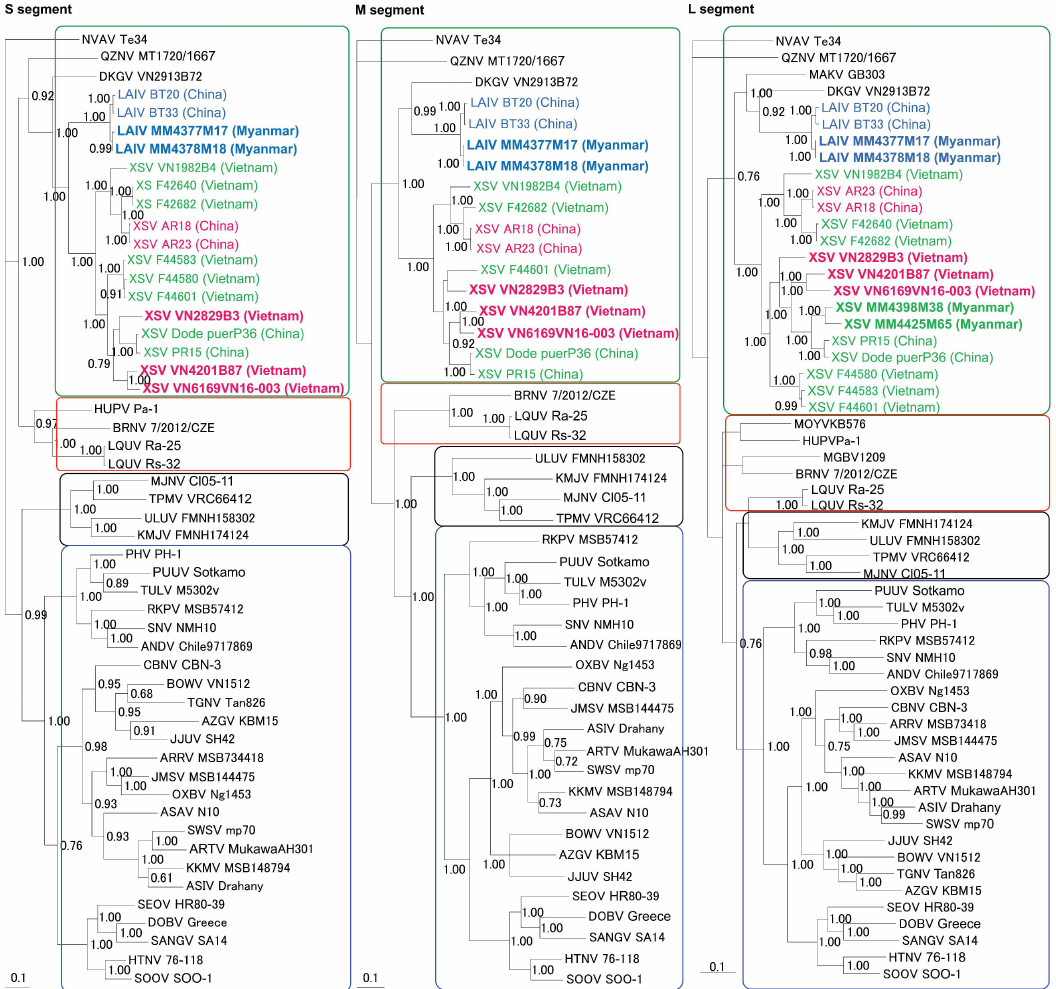
Figure 3. Phylogenetic trees, based sequences of the S-, M-, and L-genomic segments, respectively, generated by the Bayesian Markov chain Monte Carlo estimation method, under the GTR + I + Γ model of evolution. L á ib¯ın virus (LAIV) strains BT20 (S: KM102247; M: KM102248; L: KM102249), BT30 (S: KY662264; M: KY662265; L: KY662266), MM4377M17 (S: MK064114; M: MK064115; L: MK064116), and MM4378M18 (S: MK393932; M: MK393933; L: MK393934) from Taphozous melanopogon are shown